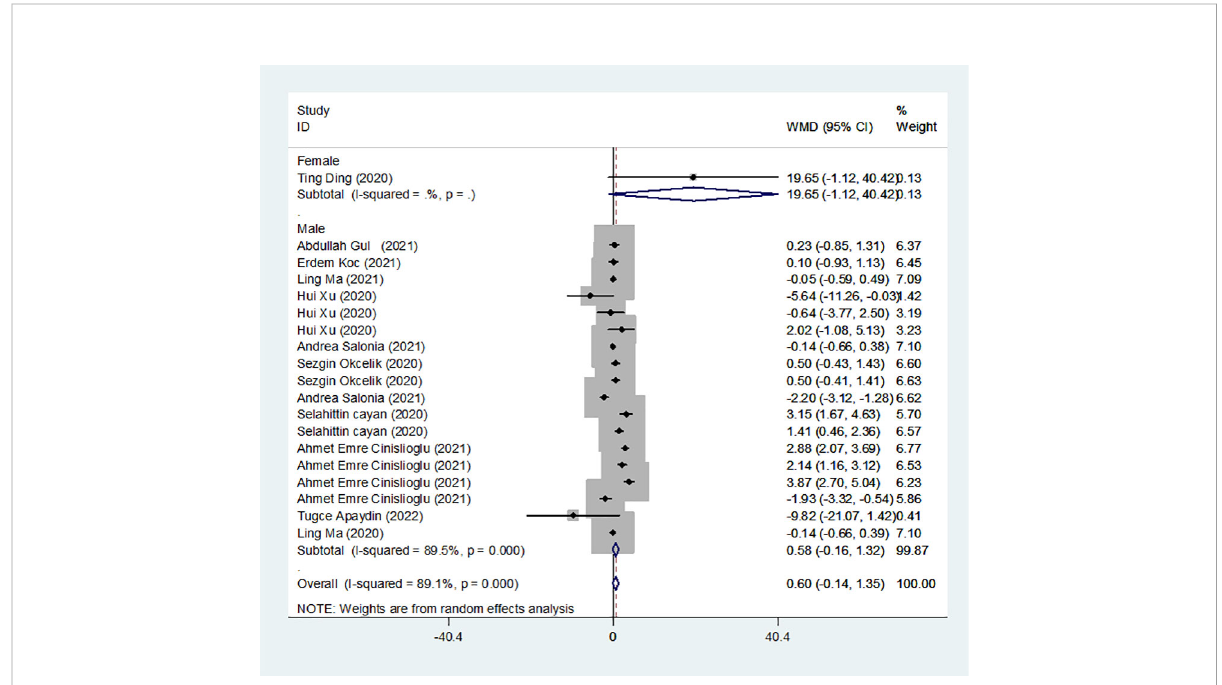
FIGURE 3 FSH levels in people with COVID-19 versus those without